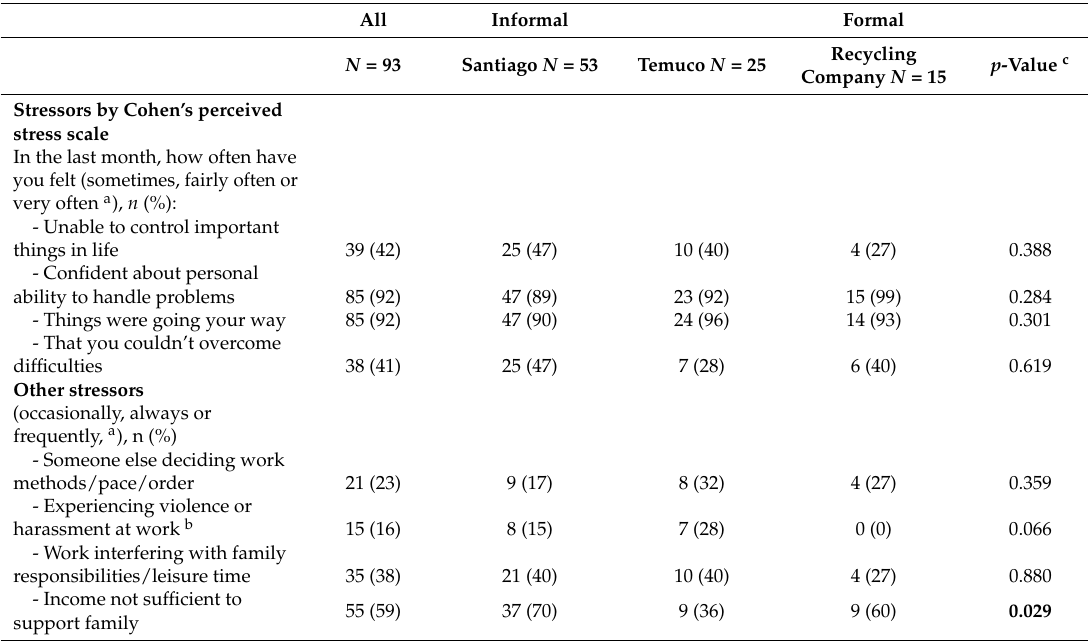
Table 5. Self-reported personal and occupational stressors in the study population, by job type and site. All Informal Formal N = 93 Santiago N = 53 Temuco N = 25